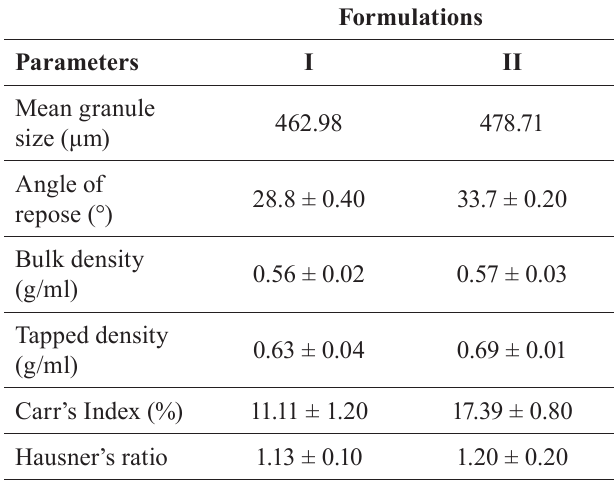
TABLE VIII - Granule parameters for the optimised